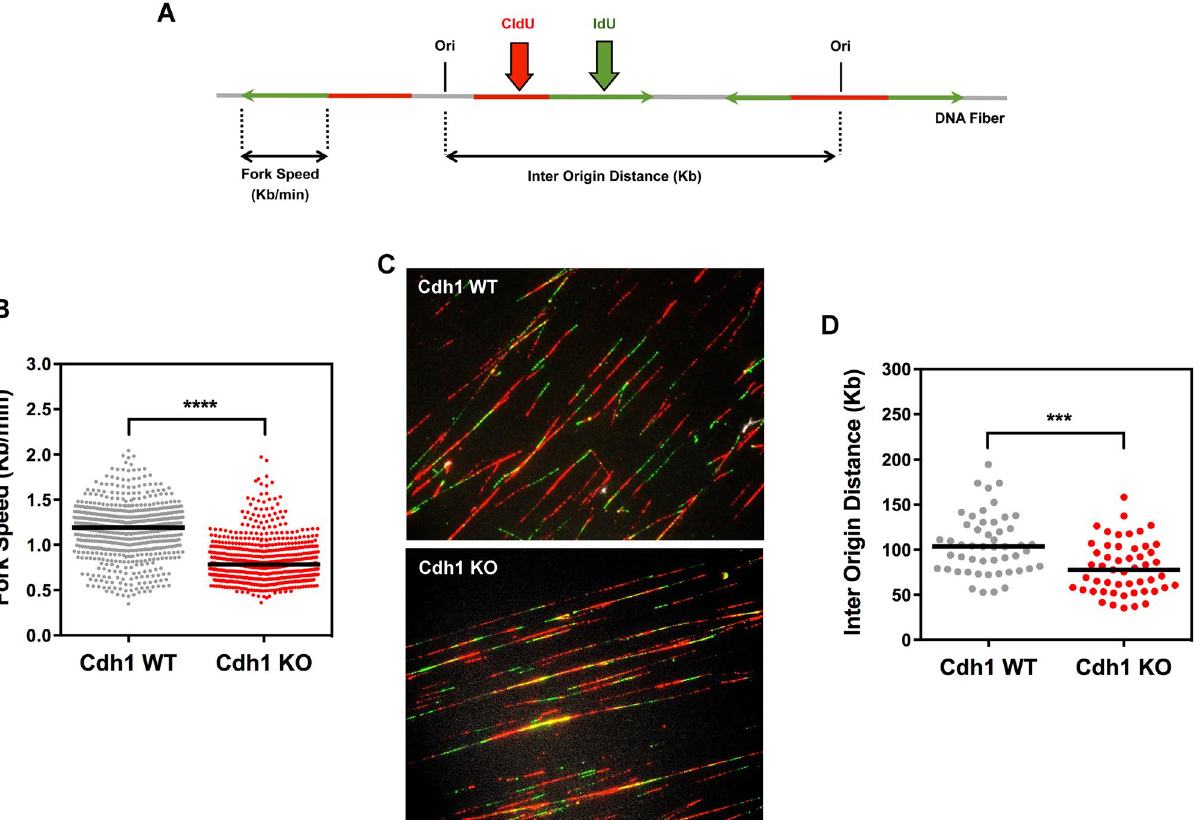
Figure 7. Aberrant replication dynamics in fetal liver cells in the absence of Cdh1. ( A ) Schematic drawing of a DNA fiber after pulse labeling with CldU (red) and IdU (green). Green track measurements allow quantification of fork speed. Origins are identified based on the pattern of green and red staining and the distance between two adjacent origins on the same DNA fiber defines IOD. ( B ) Replication fork rates were measured as detailed in ( A ) on stretched DNA fibers obtained from E14.5 fetal liver cells of the indicated genotype (n = 607 for WT and 601 for KO). ( C ) Representative immunofluorescence images of stretched DNA fibers from the indicated fetal liver cells showing CldU (red) and IdU (green) staining. ( D ) Distribution of IOD values from the same samples as in ( B ) (n = 50 for WT and 51 for KO). In scatter dot plots in ( B ) and ( D ) the black line indicates median value for the plotted data. *** P < 0.001, **** P <